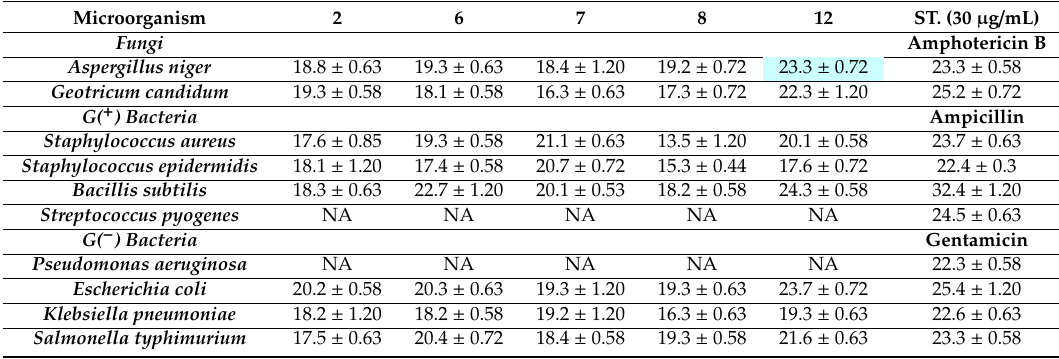
Table 4. Preliminary anti-microbial activity for compounds 13 , 14 , 17a , b and 19a . Table 3. Preliminary anti-microbial activity for compounds 2 , 6 – 8 , 12 . Table 3. Preliminary anti-microbial activity for compounds 2 , 6 – 8 , 12 . Table 3. Preliminary anti-microbial activity for compounds 2 , 6 – 8 , 12 .